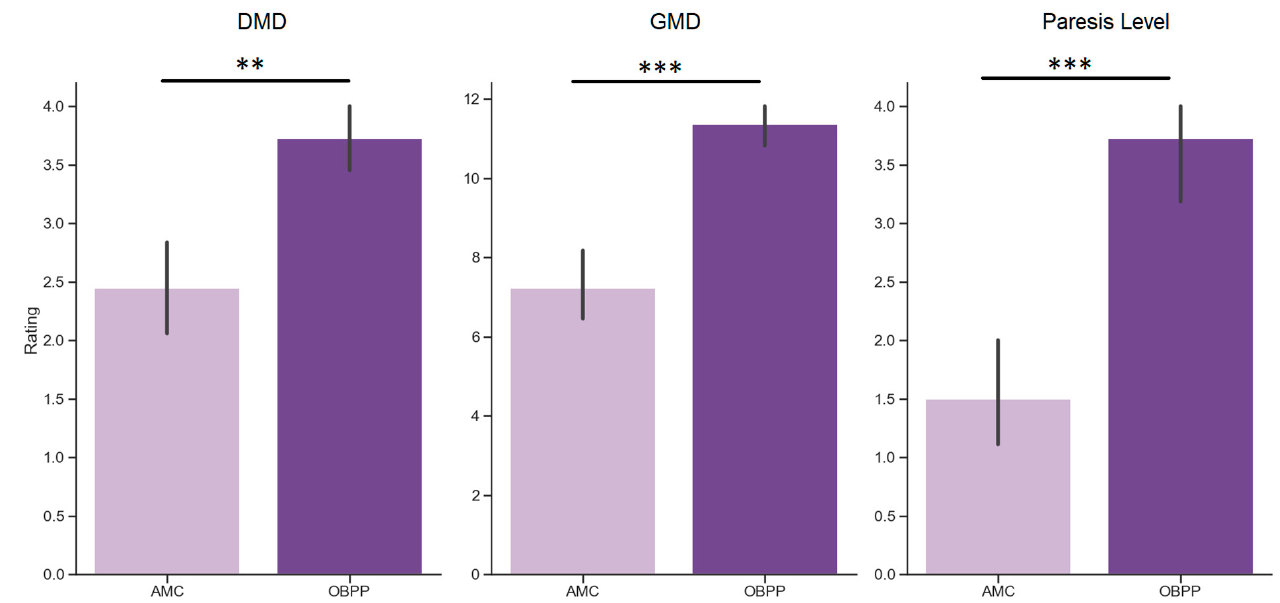
Figure 1. Motor development in AMC (light purple) and OBPP (dark purple) patients, assessed as delayed motor development (DMD) score, general motor development (GMD) score and the level of paresis (Paresis Level). Asterisks indicate significant difference for hoc Mann–Whitney u-test comparisons between the two groups of patients (** p < 0.01, *** p < 0.001).